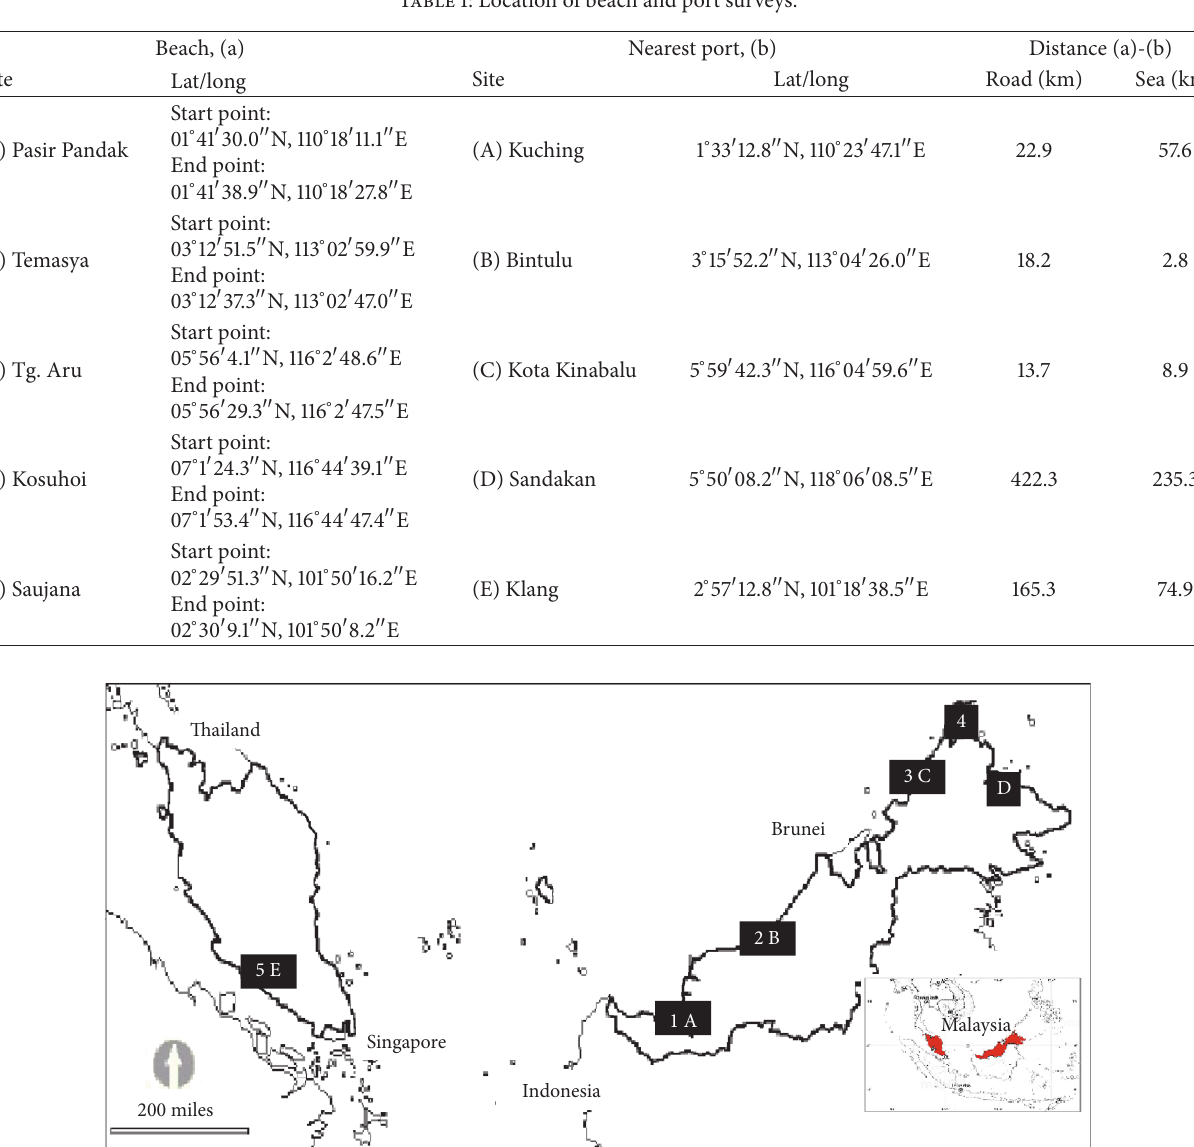
Table 1: Location of beach and port surveys.